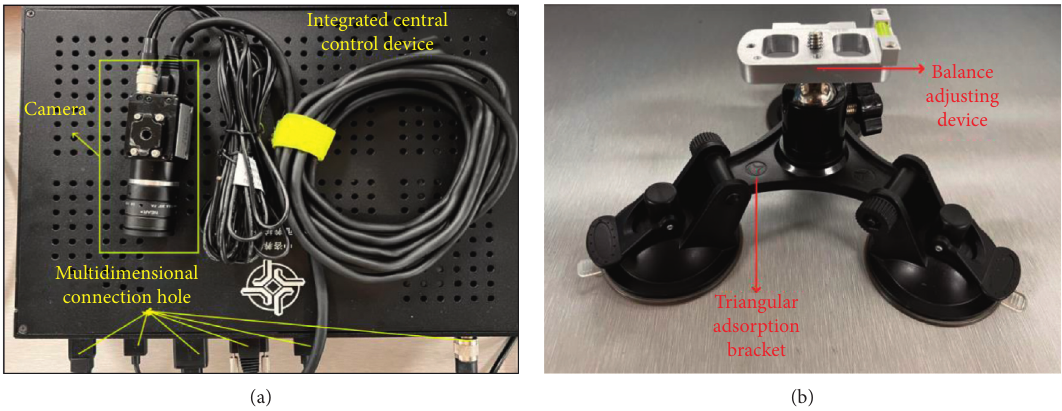
Figure 9: (a) The integrated central control device. (b) The triangle adsorption bracket.